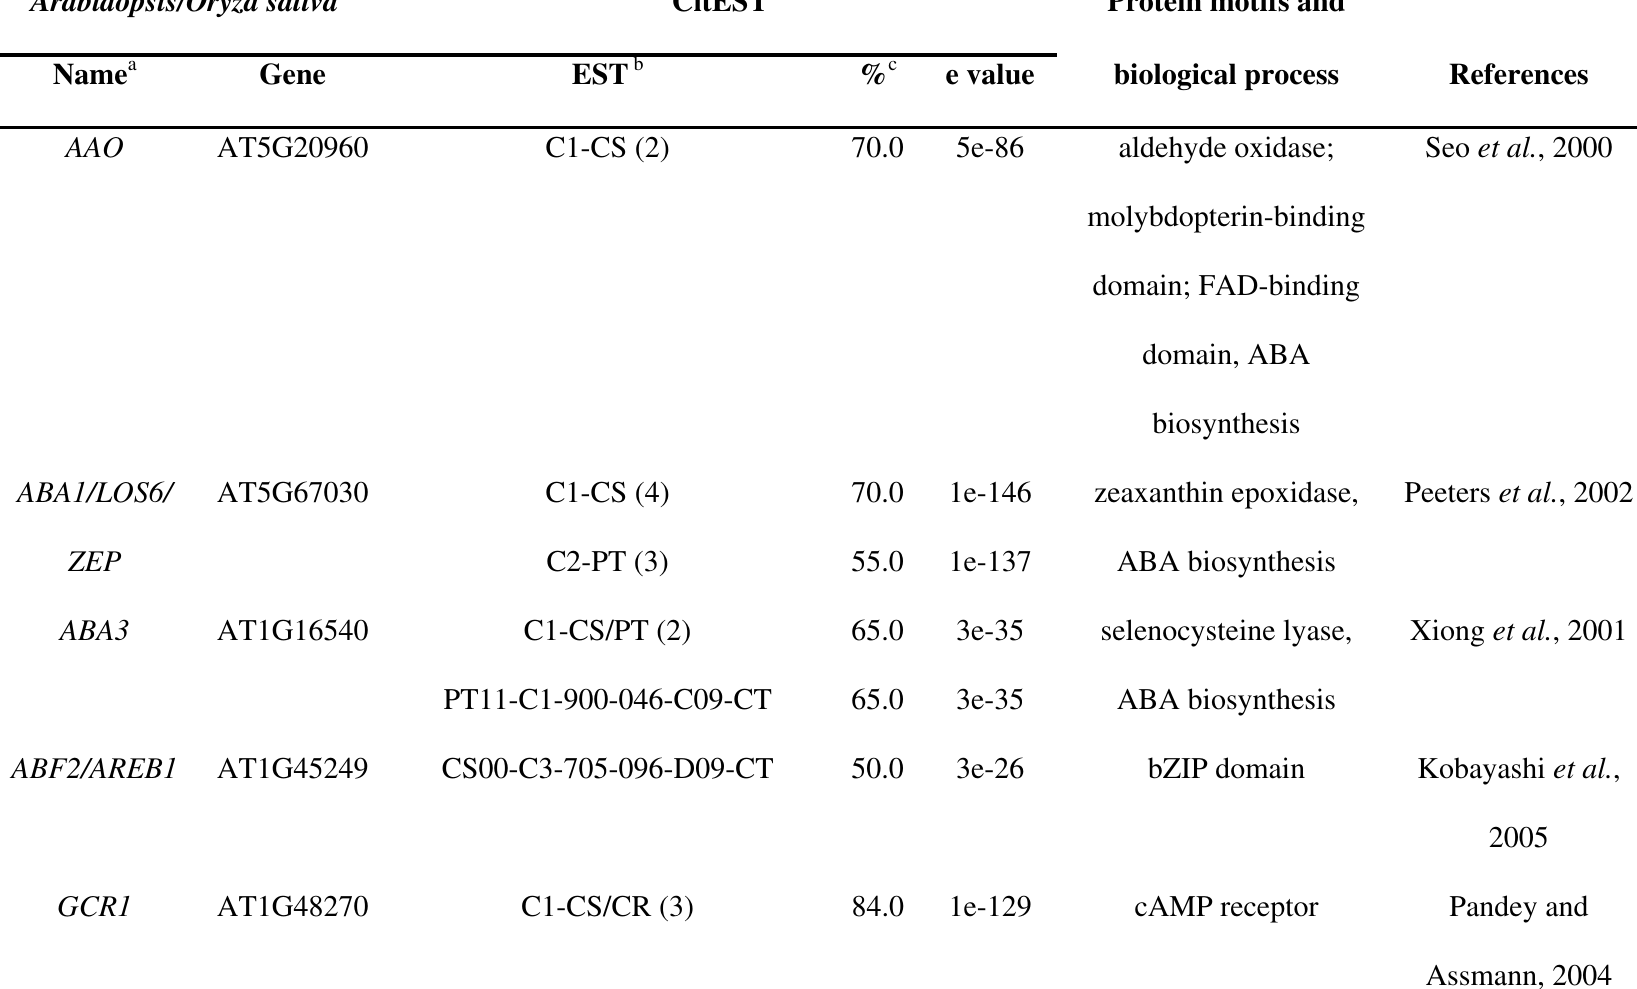
Table S1– Citrus ESTs homologous to Arabidopsis and Oryza sativa functionally-characterized ABA biosynthesis and signaling pathway